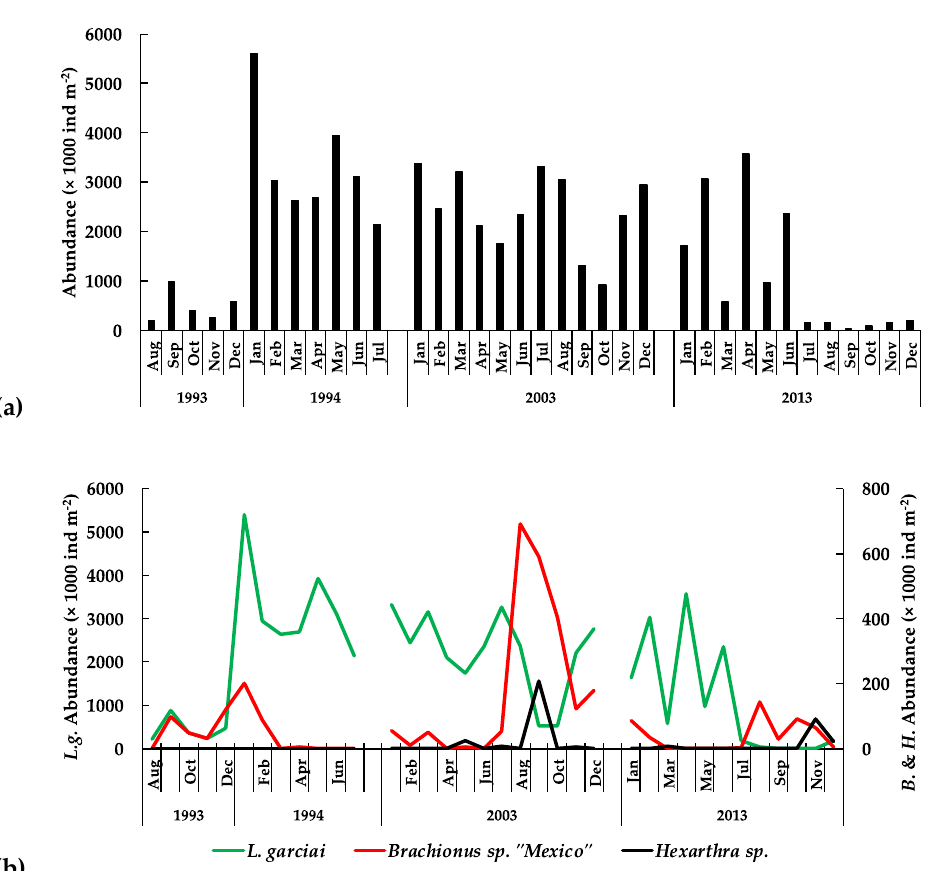
Figure 13. Temporal dynamics of ( a ) total zooplankton and ( b ) per species abundance in Lake Alchichica during 1993–1994, 2003, and 2013. ( L.g. = Leptodiaptomus garciai , B . = Brachionus sp. “Mexico”, H . = Hexarthra